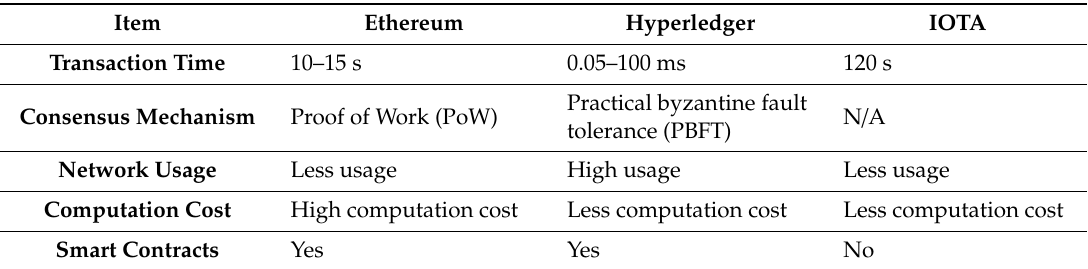
Table 4. Comparison between Ethereum, Hyperledger and